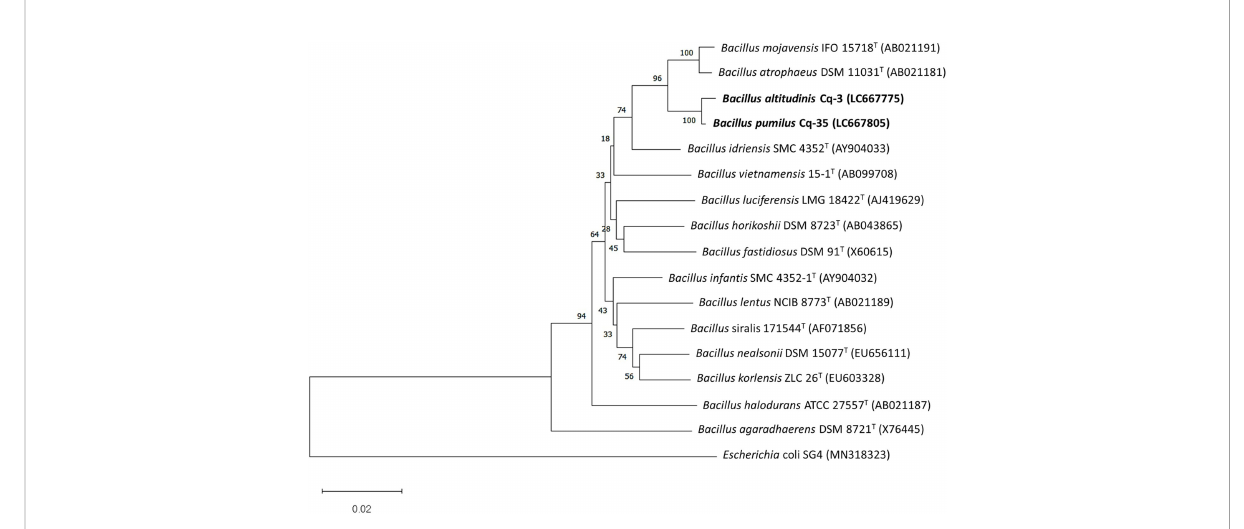
FIGURE 1 Phylogenetic tree of the strains Cq-3 and Cq-35 and related type strains within family Bacillaceae based on partial 16S rRNA gene sequences. The neighbor-joining algorithm constructed the tree in MEGA_X.